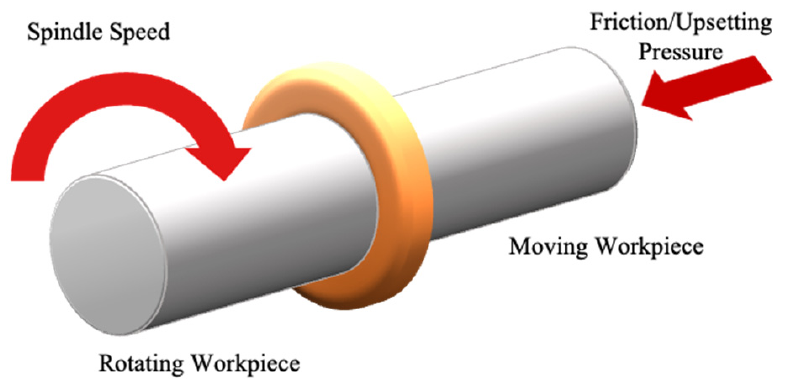
Figure 1. Schematic diagram of the CDFW process. Table 2. Process parameters of CDFW.